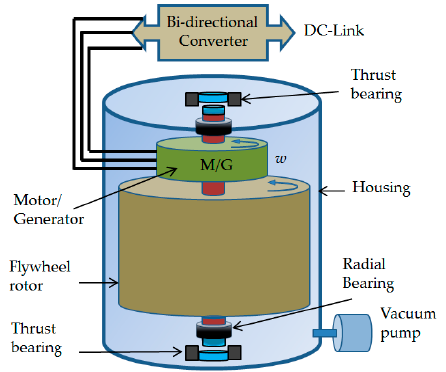
Figure 1. Structure and components of flywheel.